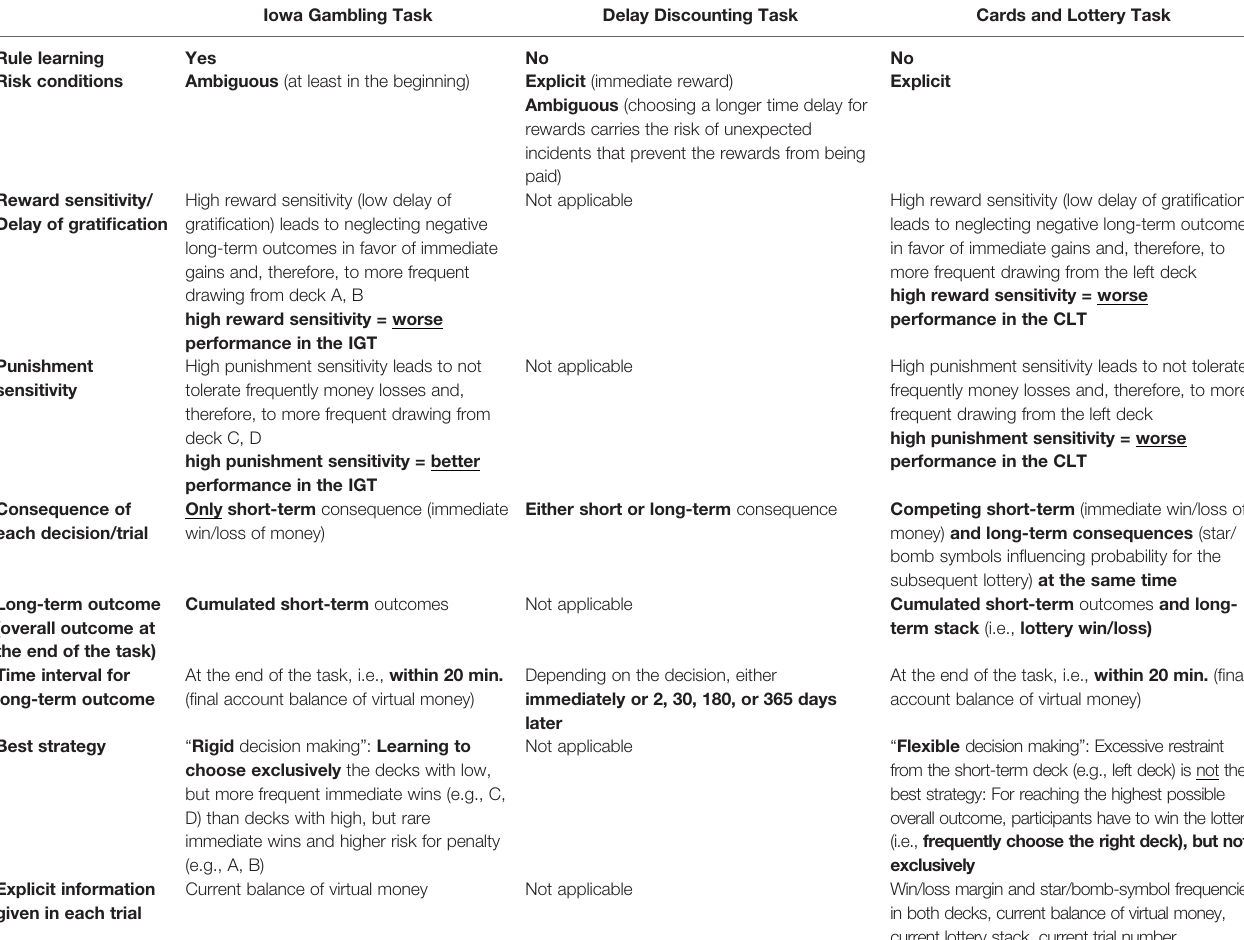
TABLE 1 | Comparison of commonly used tasks assessing decision making (Iowa Gambling Task, Delay Discounting Task), and with the newly developed Cards and Lottery